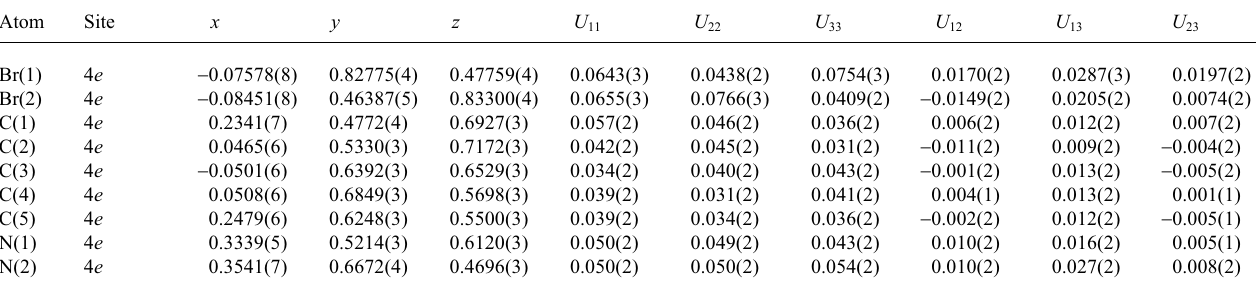
Table 3. Atomic coordinates and displacement parameters (in Å 2 )